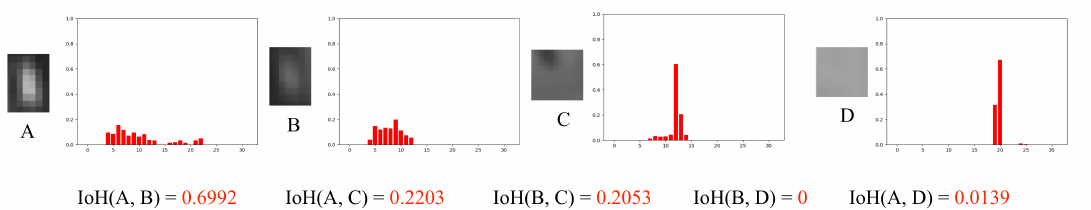
Figure 3. Histogram of Color can distinguish targets from backgrounds. Region proposal A and B are vehicles, whereas the region proposal C and D are obvious false alarms. For the four selected region proposals, their corresponding HoC are extracted, as shown in the right part of the figure. For A and B, the IoH is high, while both C and D have low IoH due to the extremely low similarities.